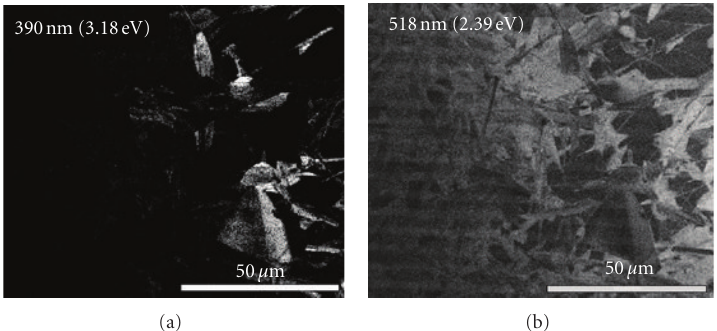
Figure 6: Monochromatic CL images of ZnO at the same region, (a) at wavelength of 390 nm mainly from flat surfaces (plaques) and (b) at 528nm, mostly from